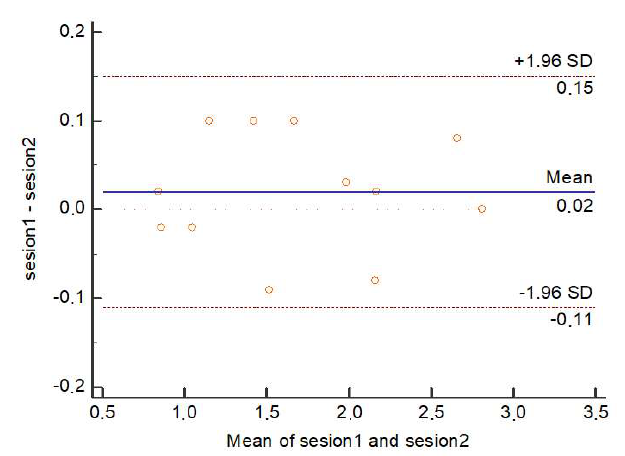
Figure 2. Bland–Altman plot comparing test-retest results for individual participants.